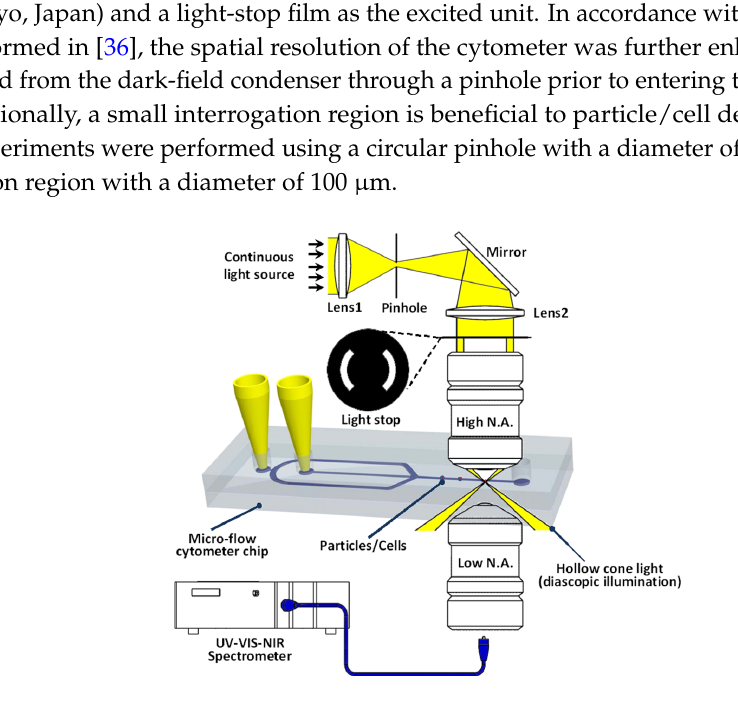
Figure 2. Schematic for the experimental setup of the proposed multi ‐ parameter cytometry detection system. N.A., numerical aperture; UV ‐ Vis ‐ NIR, ultraviolet ‐ visible light ‐ near infrared.